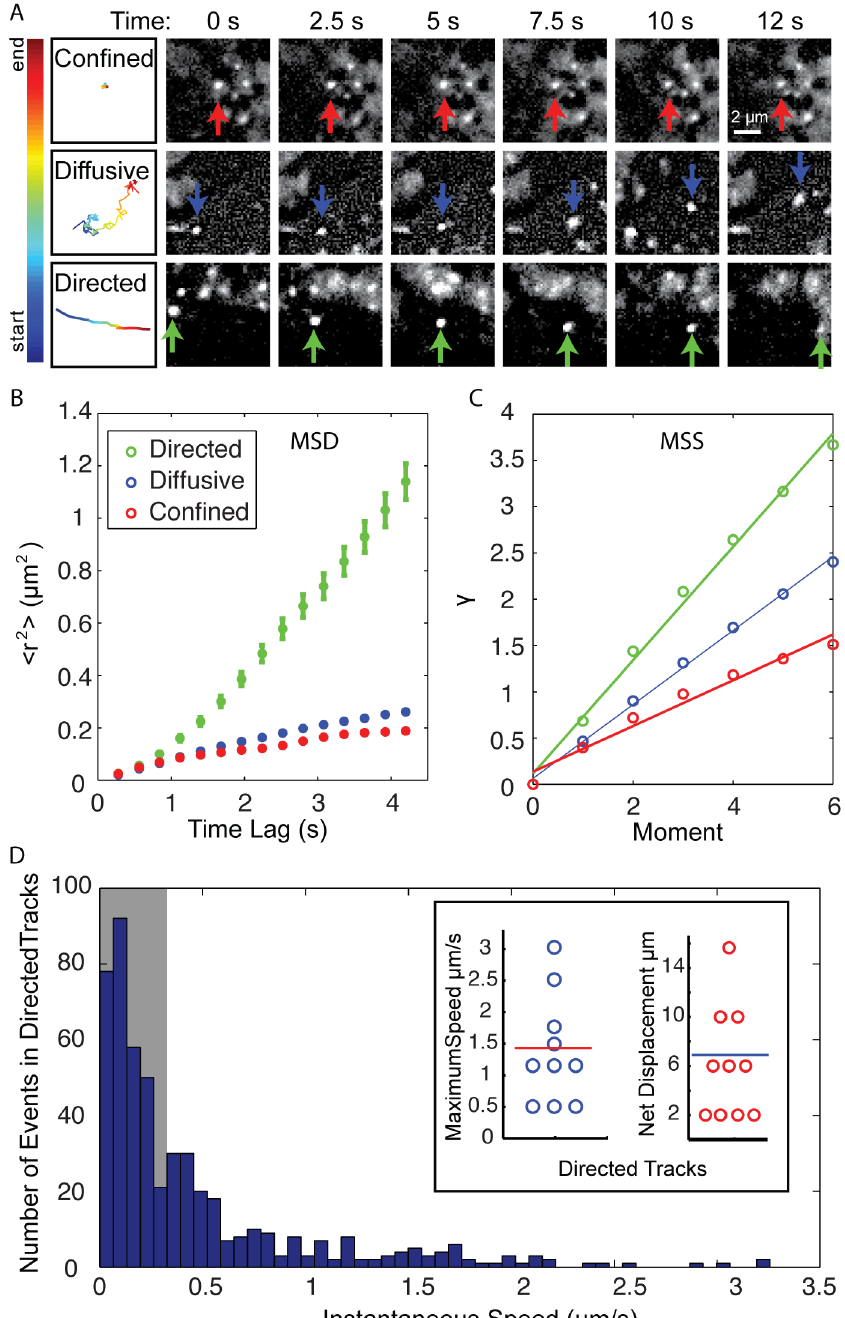
Figure 2. Analysis of RNA motion in living cells. (A) Montage of RNA transcripts classified as confined, diffusive or directed based on mean squared displacement analysis (MSD) analysis. The trajectories (far left) for the transcripts that are indicated by the arrows are color-coded for time/ frames. Scale bar: 2 m m. The motion of RNA transcripts was assessed using (B) MSD analysis and (C) motion scaling spectrum (MSS) analysis. The MSD and MSS plots represent 10 tracks per category (mean 6 SEM). (D) Analysis of the speed and distance covered by directed particles. After smoothing the position over 5 frames, the instantaneous frame-to-frame velocity was calculated for all directed tracks (N=10). A histogram of the speed distribution for all tracks is shown with a gray bar indicating speeds below our resolution limit. The inset shows the maximum speed achieved in each directed track (mean=red line, 1.4 m m/s), and the net displacement per track (mean=blue line, 7 m m).